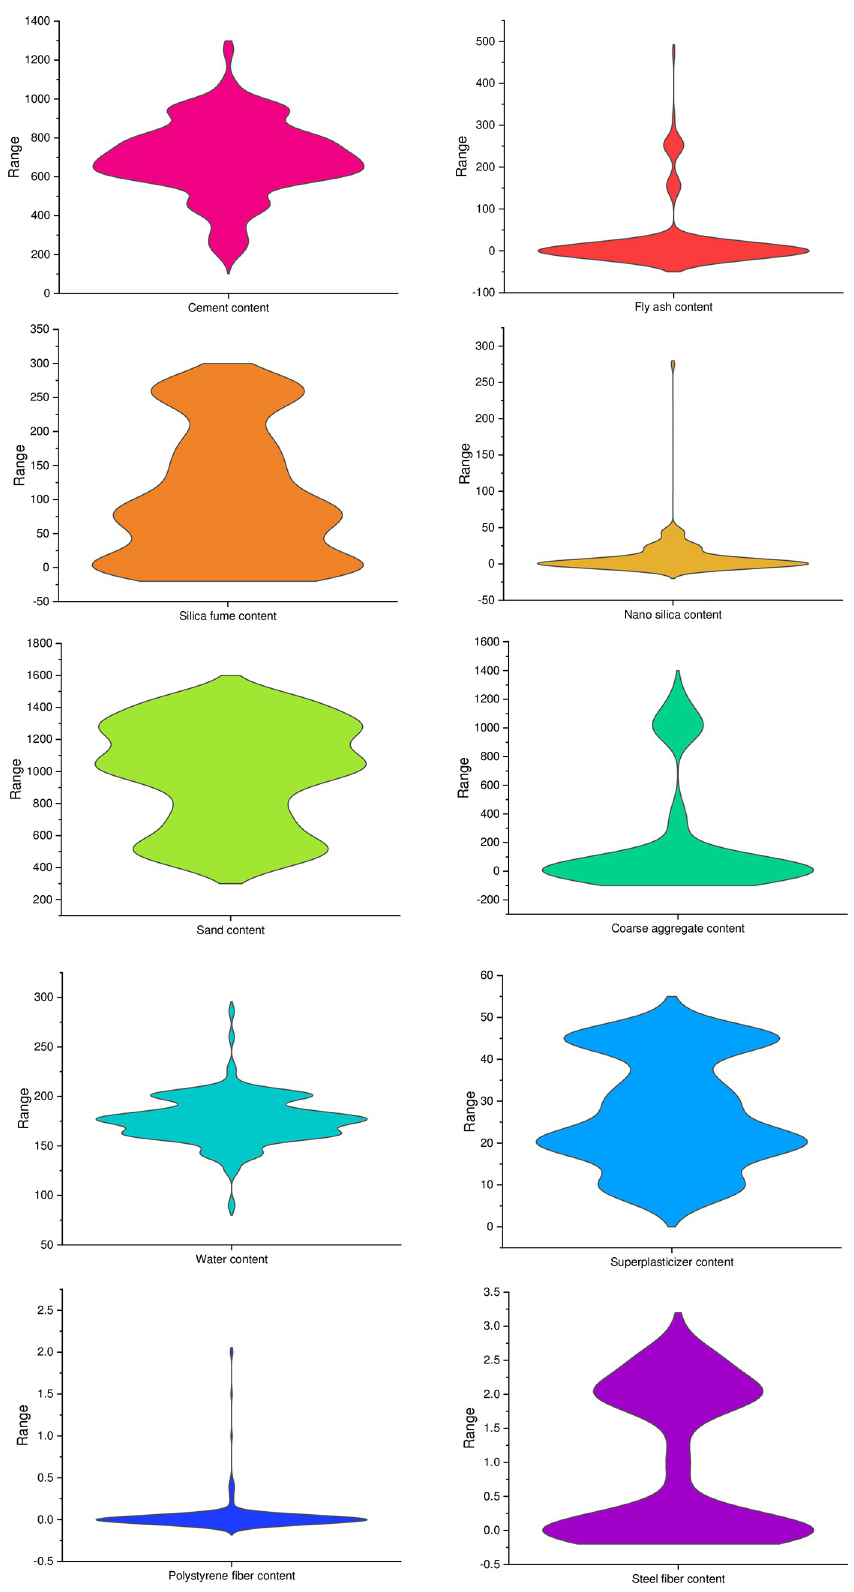
Fig 2. Violin plot for compressive strength input